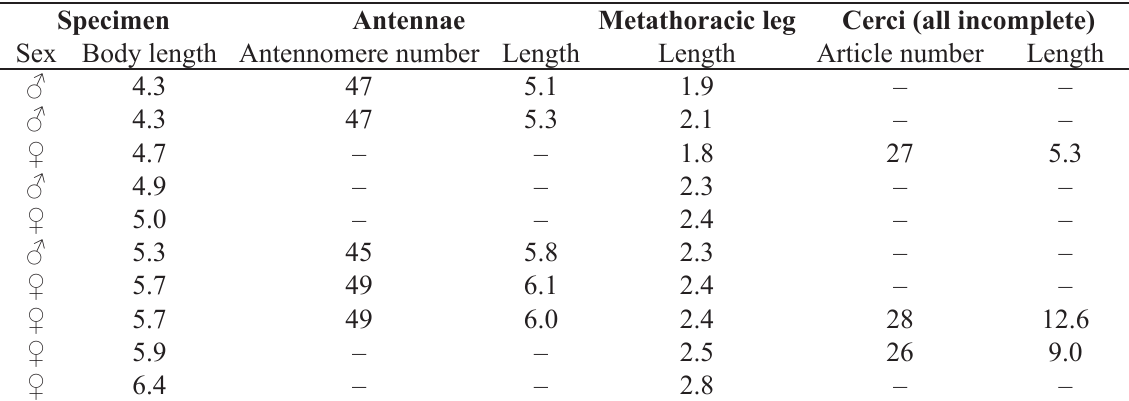
Table 2. Measurements of body, antennae, metathoracic leg and cerci in mm, including the number of antennomeres and cercal articles in a cave-adapted form of Campodea ( Dicampa ) aff. plagiaria Silvestri, 1932 from Kef Pigeons (Takebous,